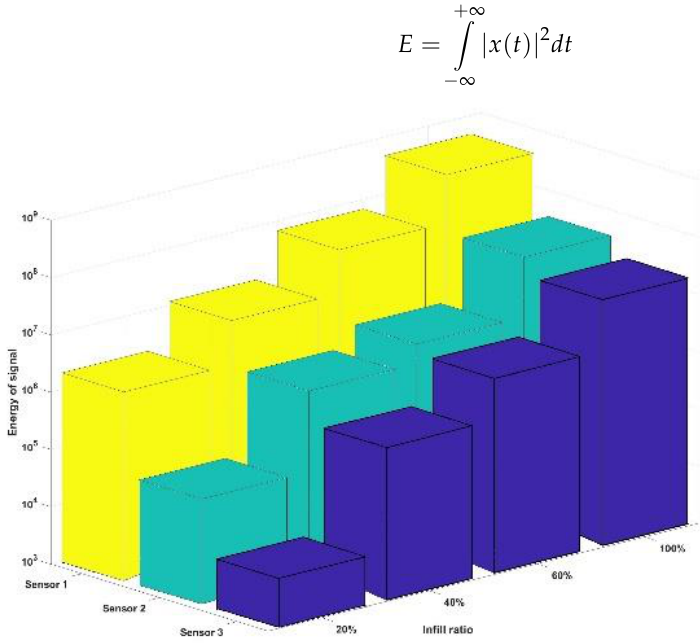
Figure 5. Energy of signal at different locations in parts with different infills .